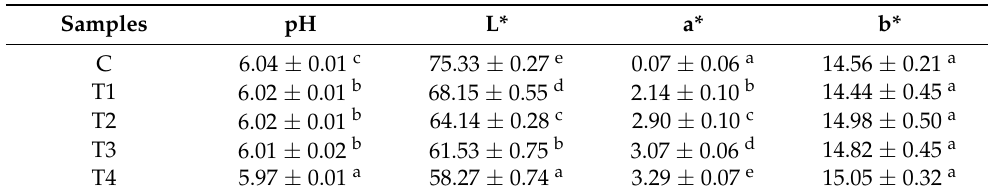
Table 4. pH value and lightness (L*), redness (a*) and yellowness (b*) values of cooked lower-fat meat batter prepared with various amounts of ORP.